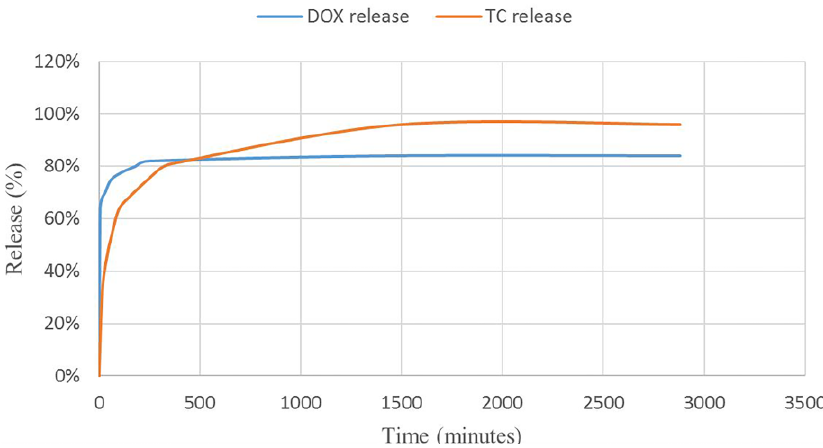
Figure 11. Release curves for TC@MIL-100 and DOX@MIL-100.